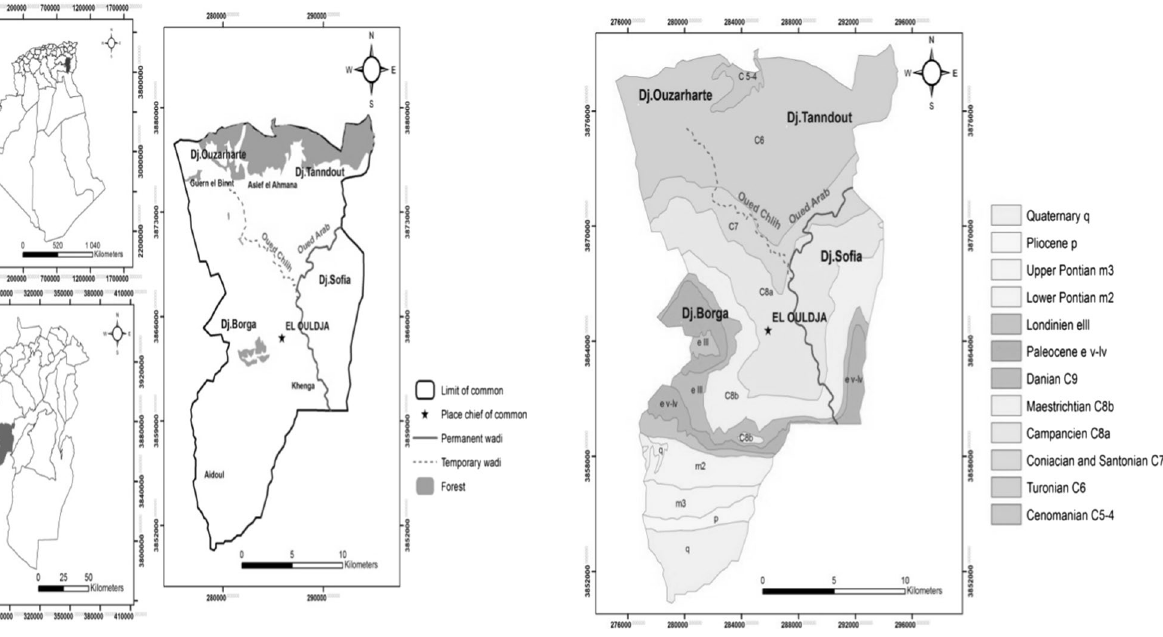
Fig. 1 Geographical location of study area Fig. 2 Geological sitting of study